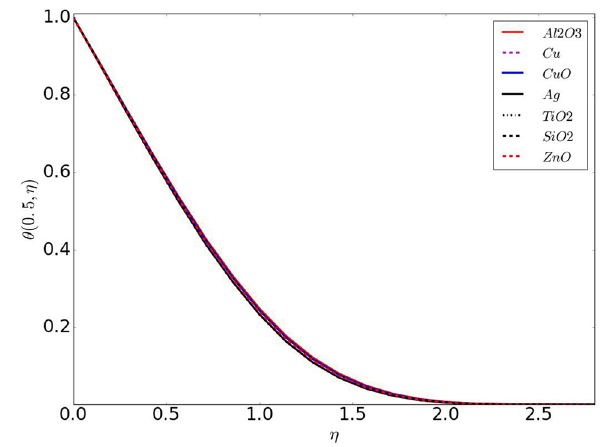
Fig. 17 Temperature Profile with various Pr with fixed 𝜉 = 0.5 and 𝜙 = 0.05 for Al 2 O 3 -water nanofluids